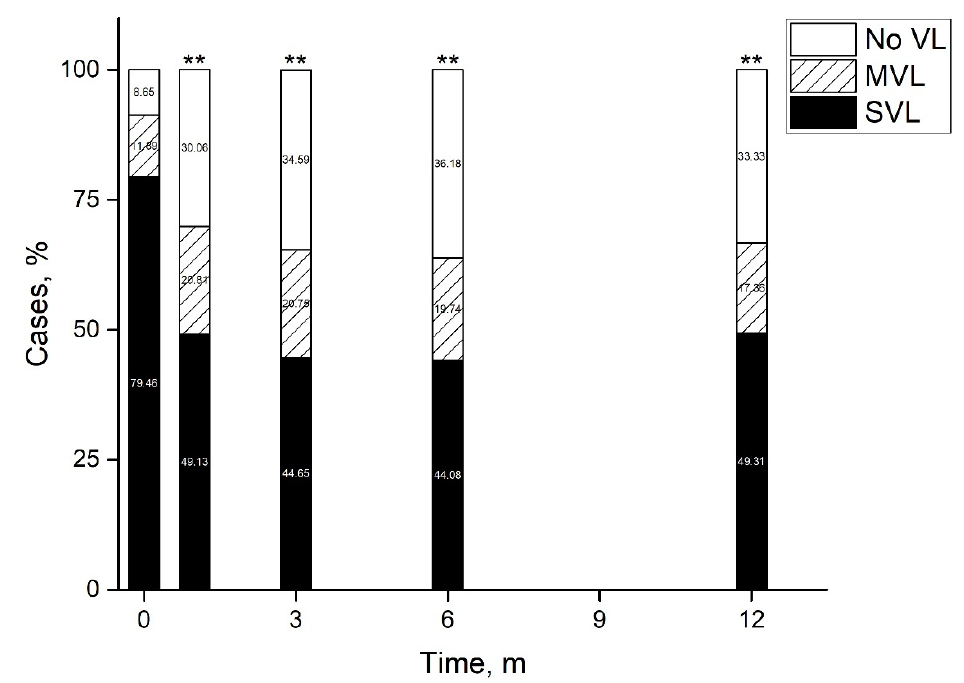
Figure 2. Vision loss patterns following acute endophthalmitis. By 12 months half of eyes had improved to a visual acuity better than 20/200 and a third had no vision loss. **— p < 0.01 (Pearson’s Chi-square test). m—months, MVL—moderate vision loss, SVL—severe vision loss, VL—vision loss. Table 1. Clinical findings and visual outcome among eyes with endophthalmitis related to post- cataract surgery, post-filtration surgery, and post intravitreal injections. Post-Cataract Surgery, Post-Filtration Post-Intravitreal p -Value n (%) Surgery, n (%) Injection, n (%) Eyes, n 71 63 Age at presentation, yrs, mean ± SEM 69.5 ± 1.5 61.4 ± 2.2 47.4 ± 4.9 4 (16.7) 7 (26.9) 3